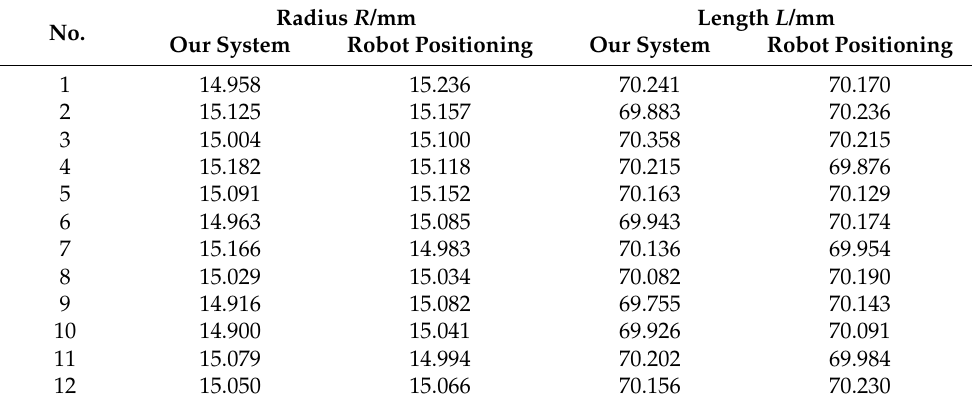
Table 6. Measurement results of the standard sphere radius and gauge block